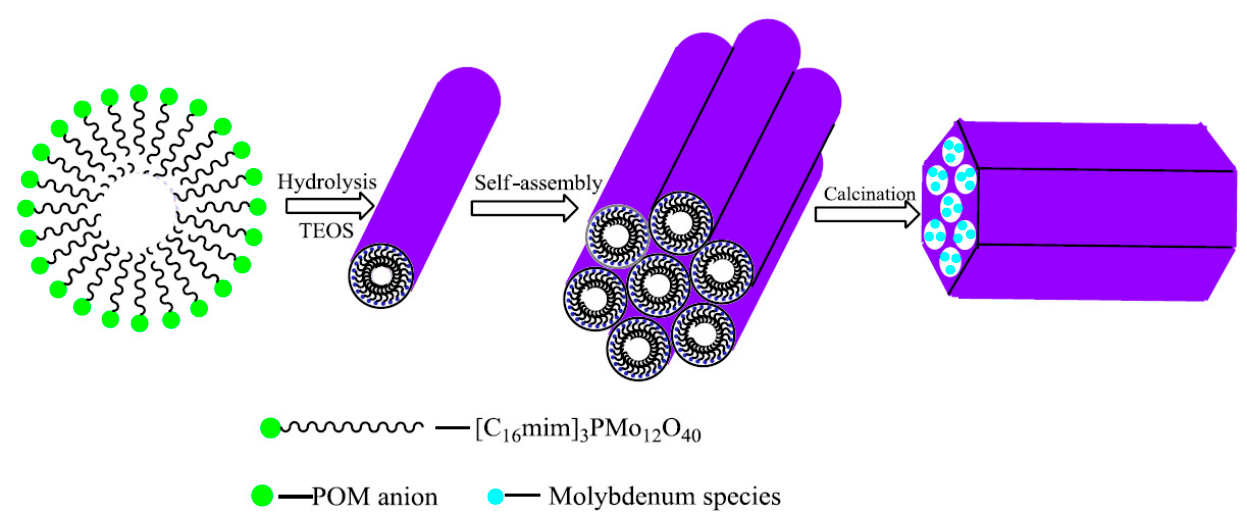
Figure 14. Schematic representation for the fabrication of functional molybdenum-containing mesoporous silica nanoparticles [201]. Reprinted with permission from ref. [201]. Copright 2021 Elsevier.